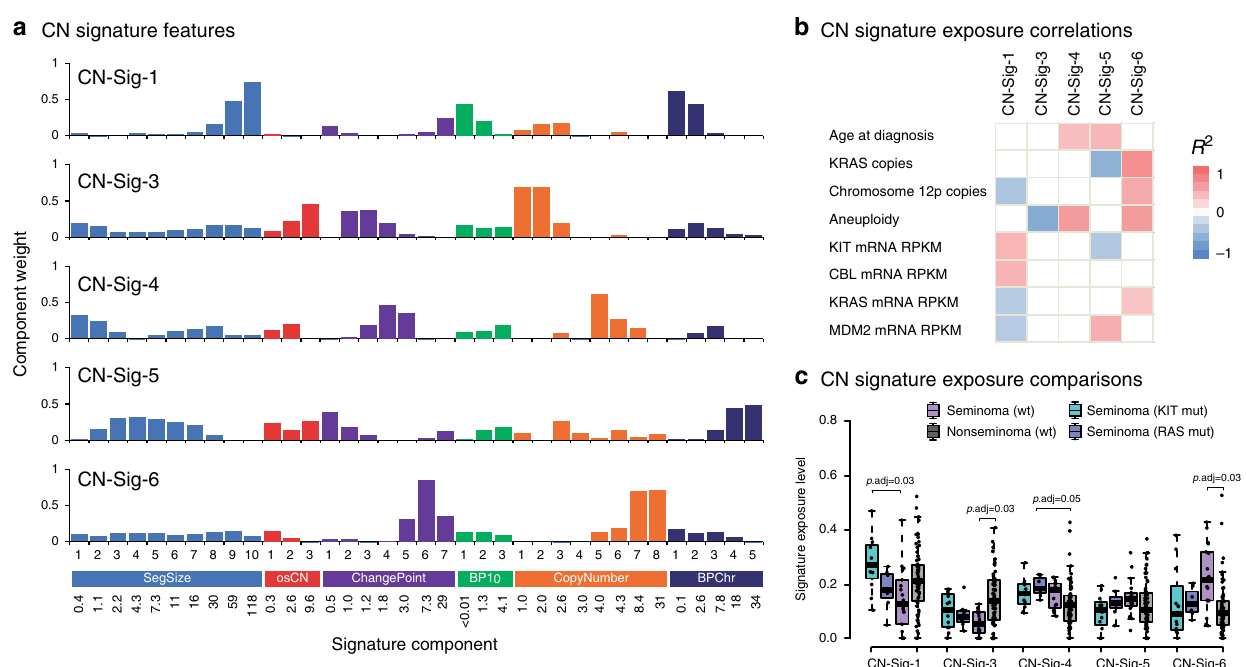
Fig. 7 TGCT copy number signatures. Five copy number signatures (CN-Sig-1, CN-Sig-3, CN-Sig-4, CN-Sig-5, CN-Sig-6) identi fi ed using TCGA SNP array data ( n = 105). a De fi ning features of the CN signatures, showing each feature (SegSize, osCN, ChangePoint, BP10, CopyNumber and BPChr) split into 36 constituent components, as de fi ned in ref. 27 . The mean value for each component is shown on the x axis, with component weights shown on the y axis. Features are de fi ned as follows: SegSize, segment size (Mb); ocCN, region length with neighbouring oscillating copy number segments (Mb); ChangePoint, difference in copy number between neighbouring segments; BP10, number of break points (10 Mb − 1 ), CopyNumber, absolute copy number of segment; BPChr, breakpoints per chromosome arm. b CN signature exposure correlations with clinical and molecular features. Two-sided Pearson ’ s correlations for association of q < 0.05 are illustrated. Age, aneuploidy and chromosome 12p copies: analysed across histologies. RAS pathway-related features: analysed in seminomas only. c Box plots showing CN signature exposure comparisons for KIT ( n = 12) and RAS ( n = 7, NRAS / KRAS ) mutated seminomas, wildtype seminomas ( n = 18) and nonseminomas ( n = 66). Boxes show the median ± 25 – 75th percentiles, whiskers show 1.5× interquartile range below and above the 25th and 75th percentiles, respectively. p values are derived from two-sided Wilcoxon Rank Sum tests adjusted for multiple comparisons via the Benjamini-Hochberg